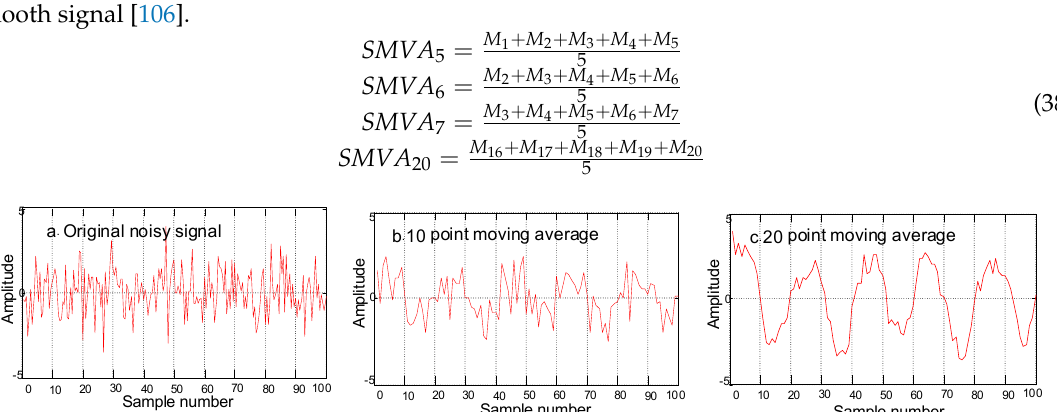
Figure 28. ( a ) Noisy signal, ( b , c ) signal with 10- and 20-buffer samples point.